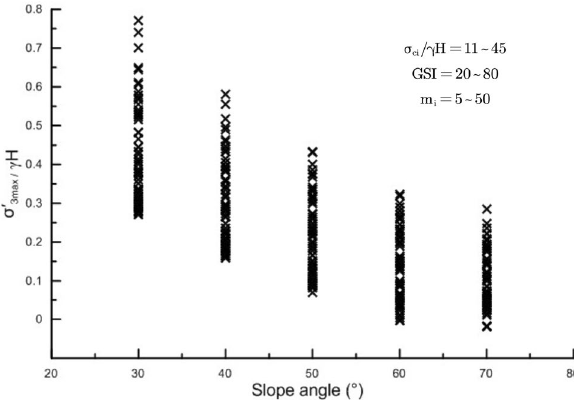
σ ′ 3,max γ H for various slope